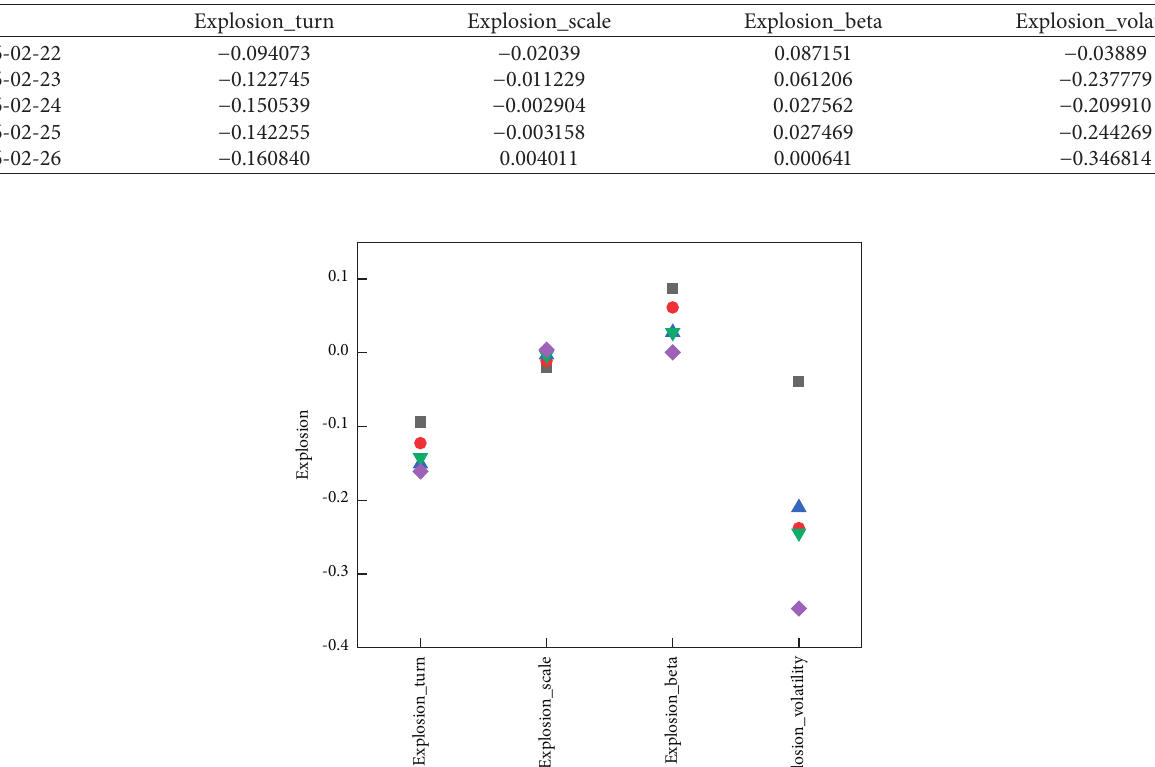
Table 3: Multifactor attribution analysis model.